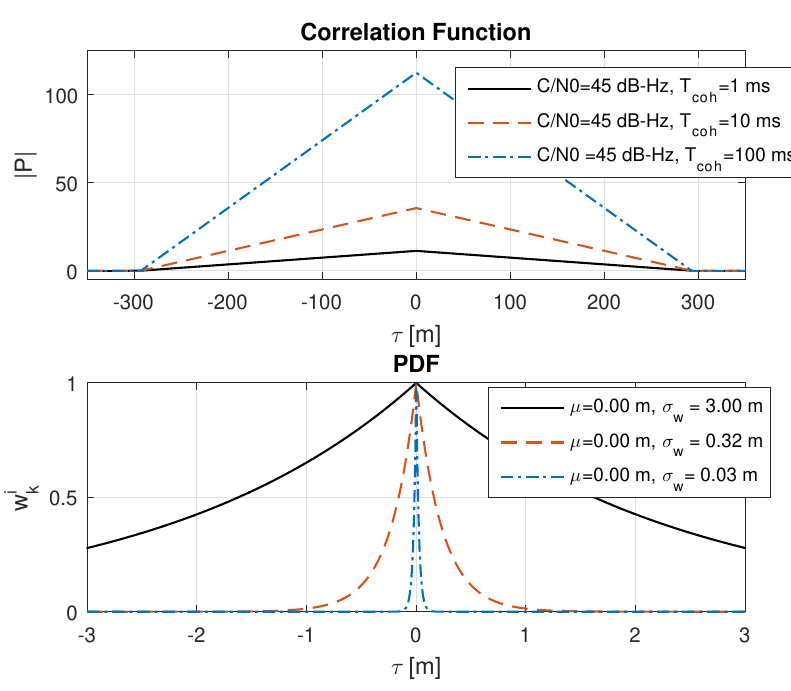
Figure 4. The plot is based on a MATLAB [31] simulation (Release 2015b, The MathWorks Inc., Natick, MA, USA). The upper plot shows the correlation function from Equation (15) for different coherent integration times at a C/N0 = 45 dB-Hz. The simulated signal was generated without noise (i.e., the C/N0 merely defines the correlation amplitude). The lower plot shows the corresponding probability function after one weight update Equation (36), for one signal N = 1 and assuming a uniform = 0 is considered in Equation (34). The statistics in the distribution from the previous epoch, i.e., (cid:101) w i k − 1 lower plot refer to the weighted mean µ and weighted standard deviation σ w